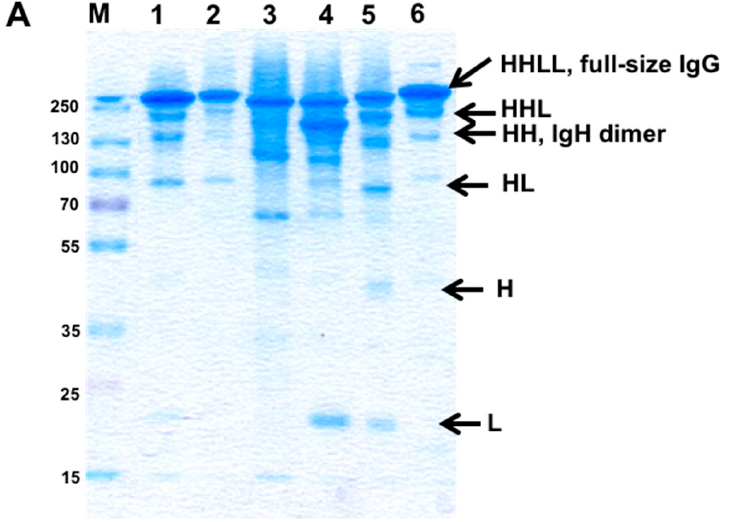
Figure 10. Evaluation of “disulfide-stabilized IgGs” and bsAbs containing tyrosine mutations by SDS/PAGE. 1. Heavy chain α SA Q175C C222Y + Light chain α SA E160C C214Y; 2. T427 WT (Heavy chain T427 WT + Light chain T427 WT); 3. Heavy chain T427 G44C C222Y + Light chain T427 G100C C214Y; 4. BsAb: α SA-Heavy chain Q175C C222Y hole + Light chain E160C C214Y and T427-Heavy chain G44C C222Y knob + Light chain G100C C214Y; 5. BsAb: T427-Light chain G100C C214del and